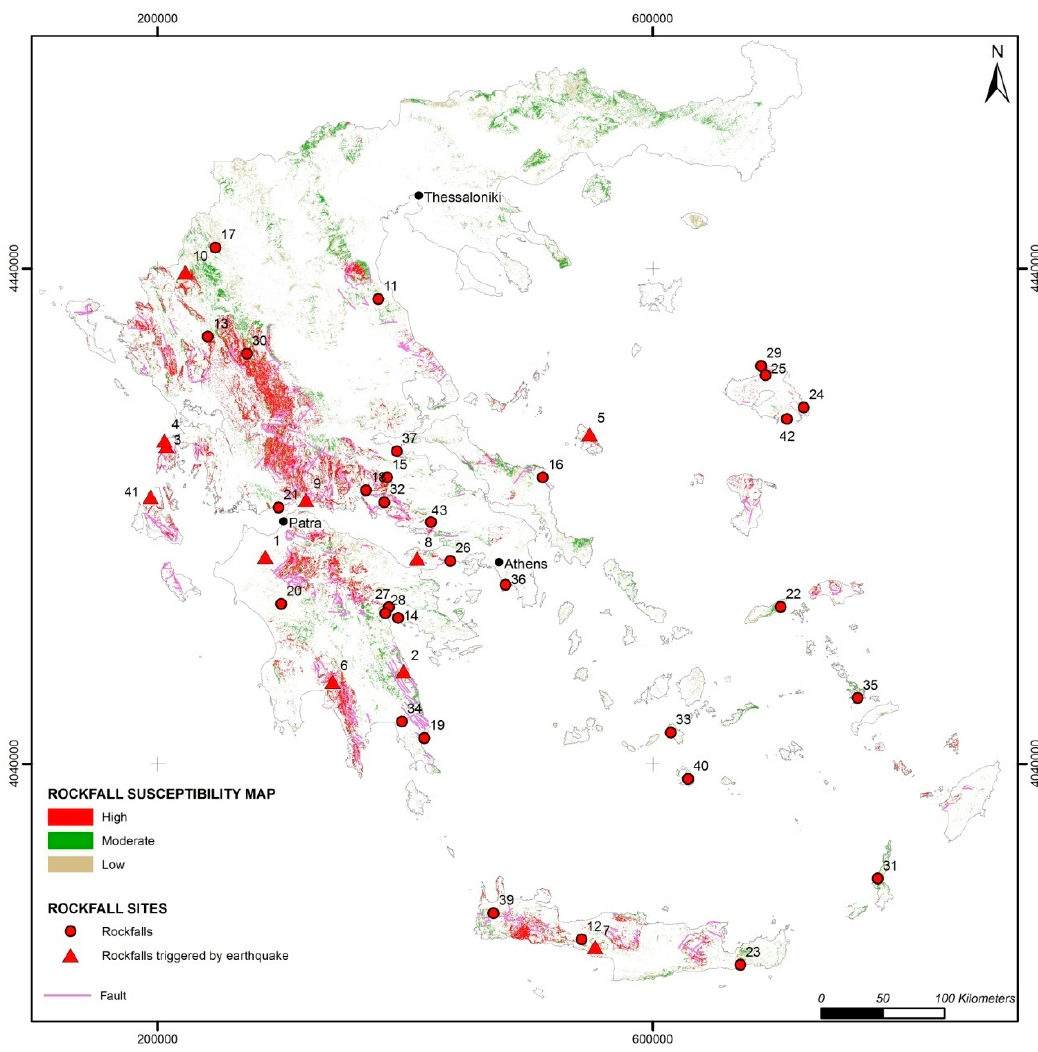
Figure 12. Rockfall susceptibility map and inventory of rockfalls in Greece.